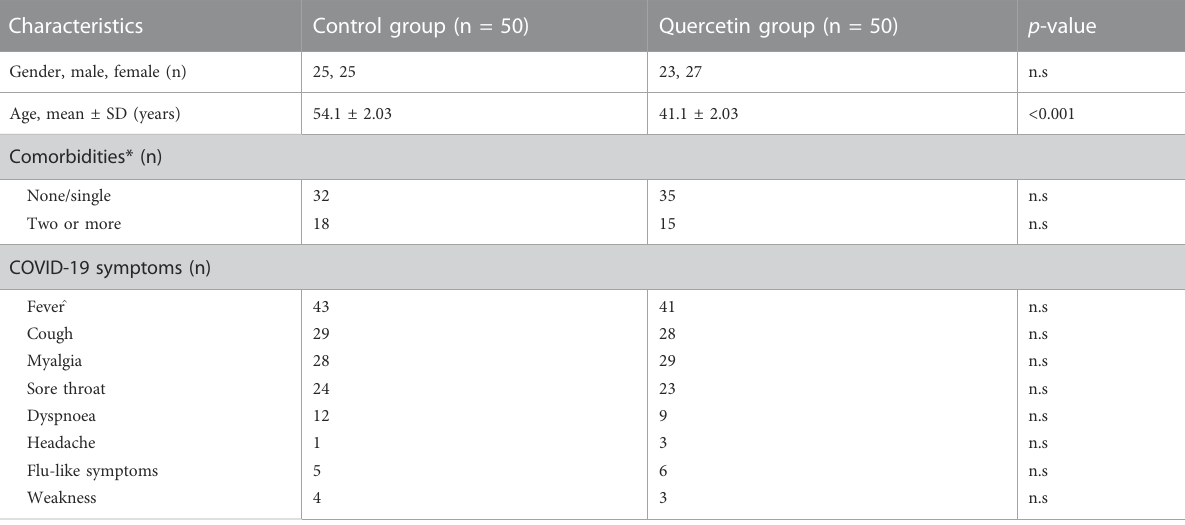
TABLE 1 Patient ’ s demographics and baseline clinical characteristics.